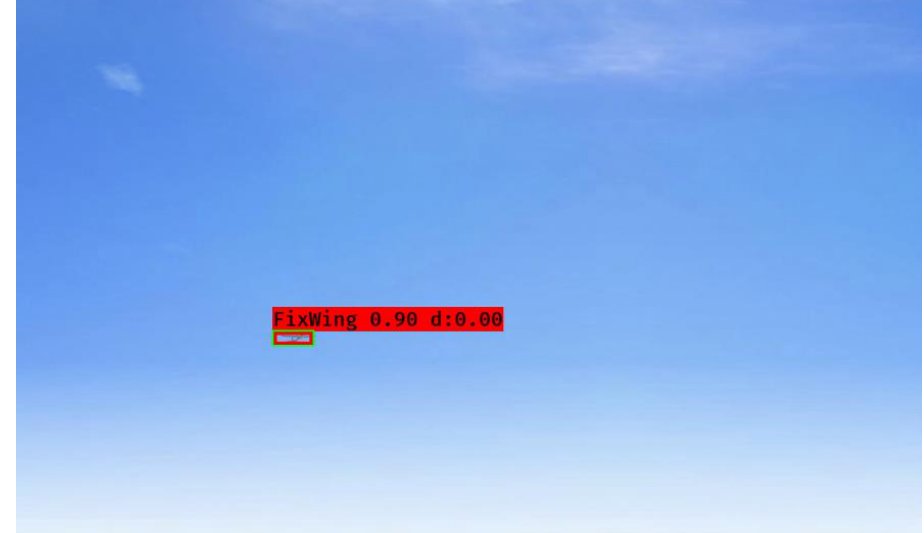
Figure 4. Detection results of the custom you only look once (YOLO)v3 detector on synthetic images.